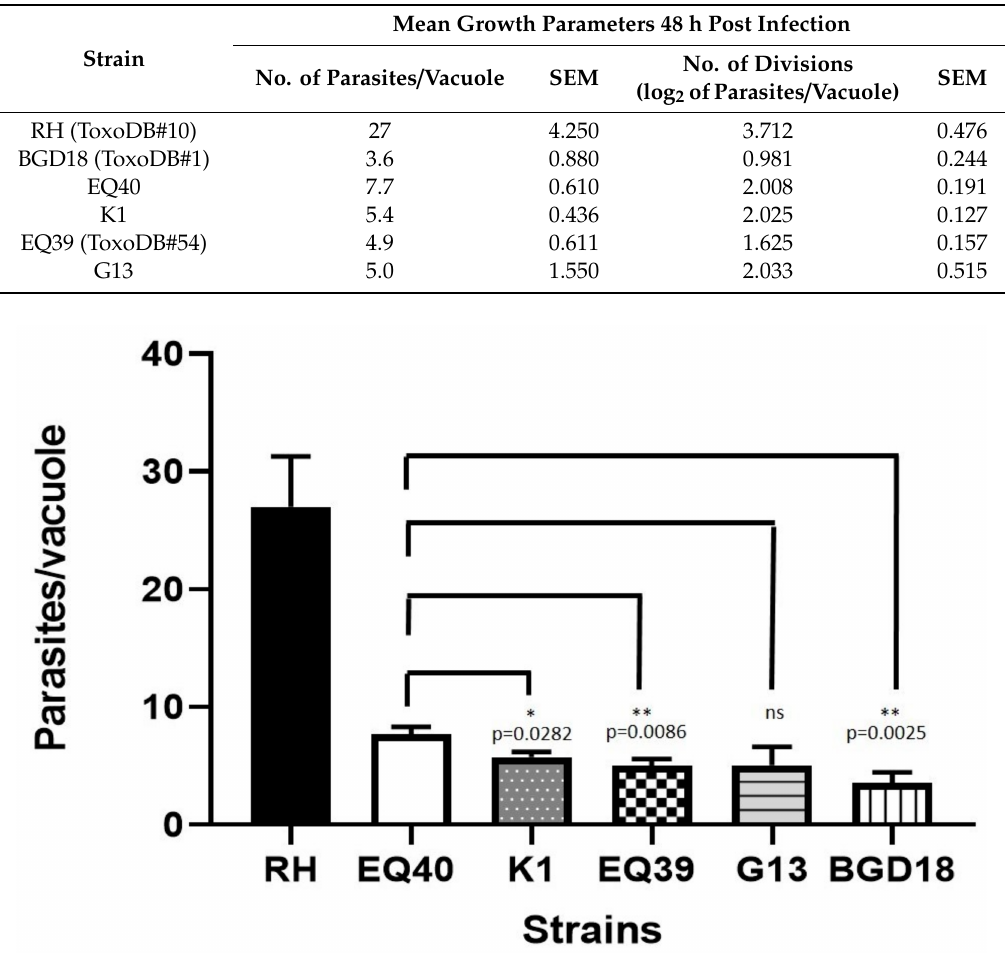
Table 5. In vitro proliferation parameters.